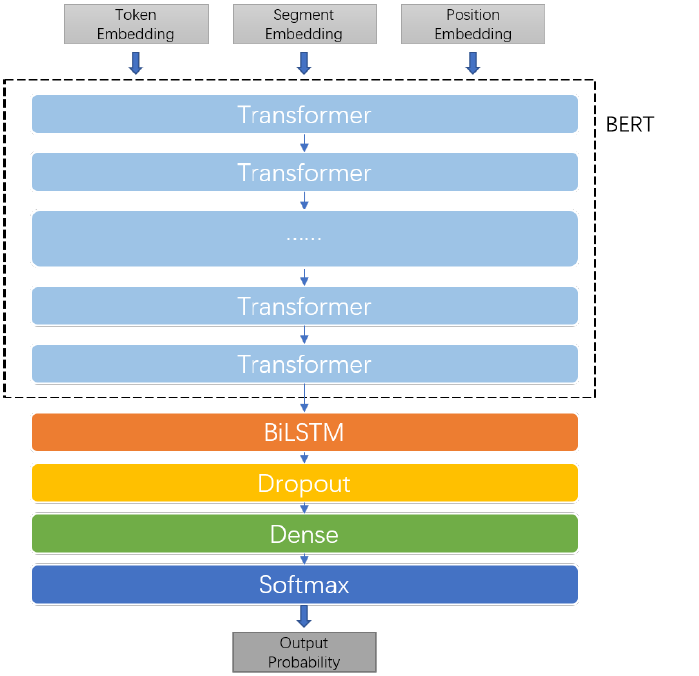
Figure 7. Classification network structure in the Semantic Relationship Detection experiment.